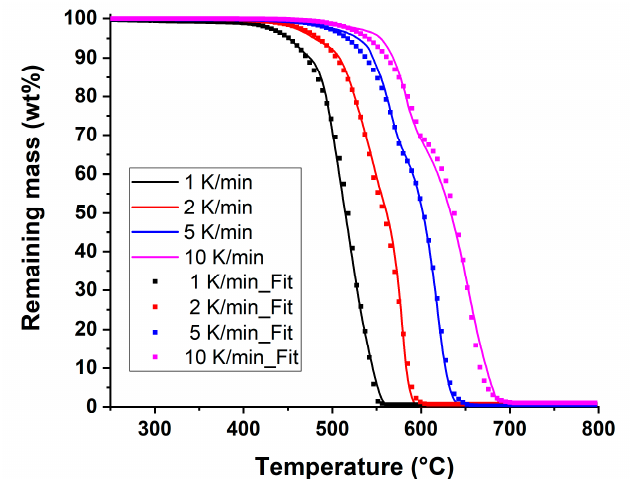
Figure 17. Best fit of the TG data for the three-step reaction models in Scheme 3, with the parameters given on Table 4. The curves represent the experimental data and the symbols represent the model.